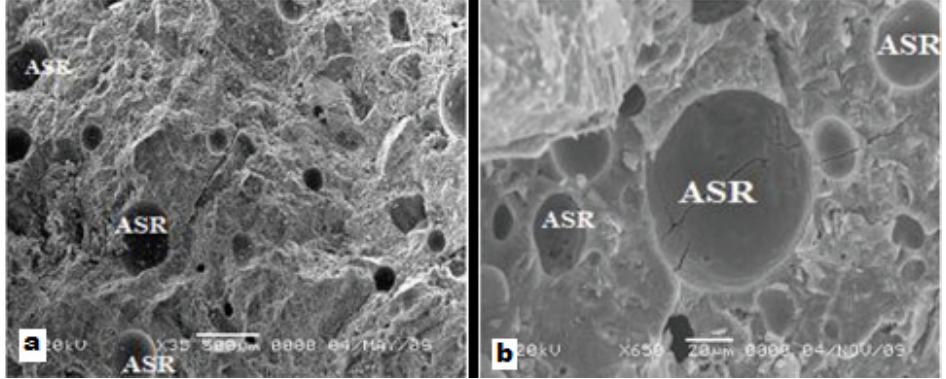
Figure 2. ASR products monitored via SEM, ( a ) 35×; ( b ) 650×. The effects of alkali-silica reactions were investigated by scanning electron microscopy (SEM) for mortar samples of granite aggregates and CEM I 42.5R Portland cement [34]. cause cracks that create a volumetric expansion due to alkali-silica reactions, as shown in Figure